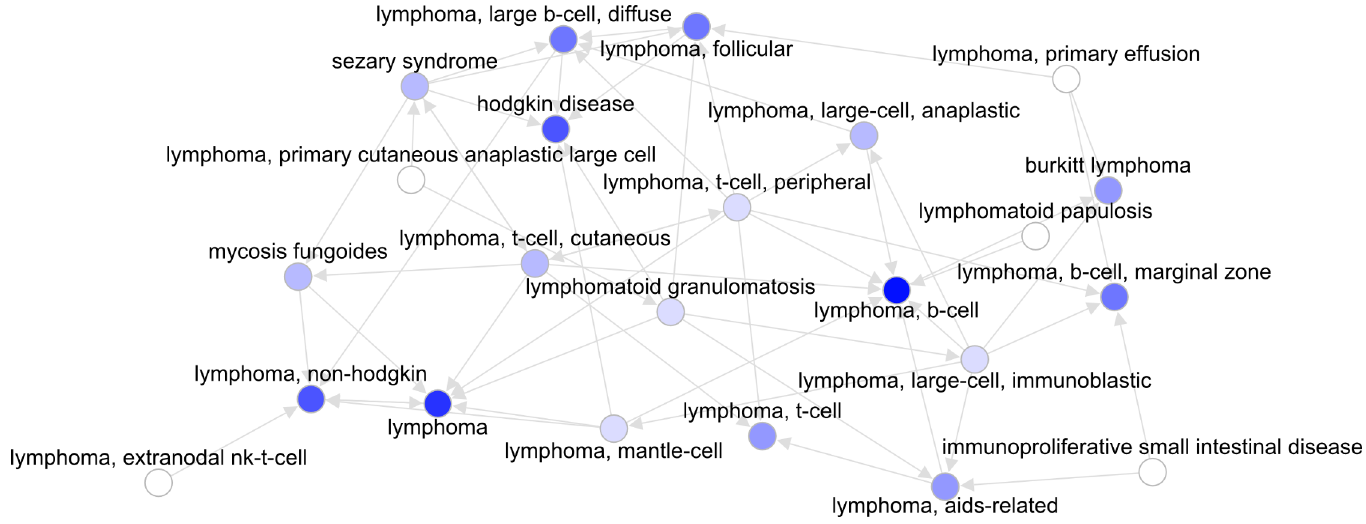
Fig 4. Lymphoma subnetwork based on the Literature dataset. Node colors are based on in-degree.